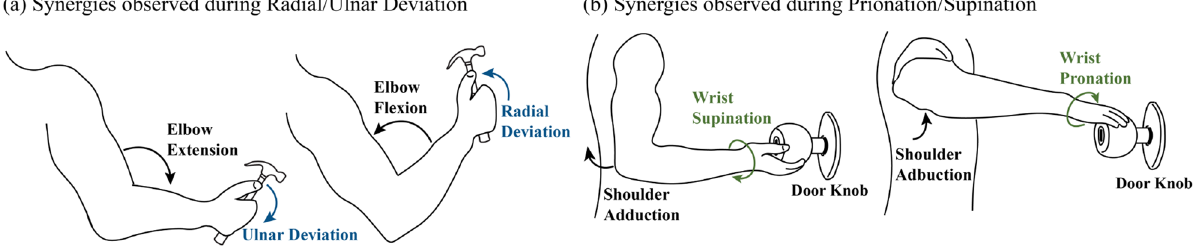
Figure 5. Postural synergies exhibited by the participants during hammering task and door knob (pulley in the experiment) rotating